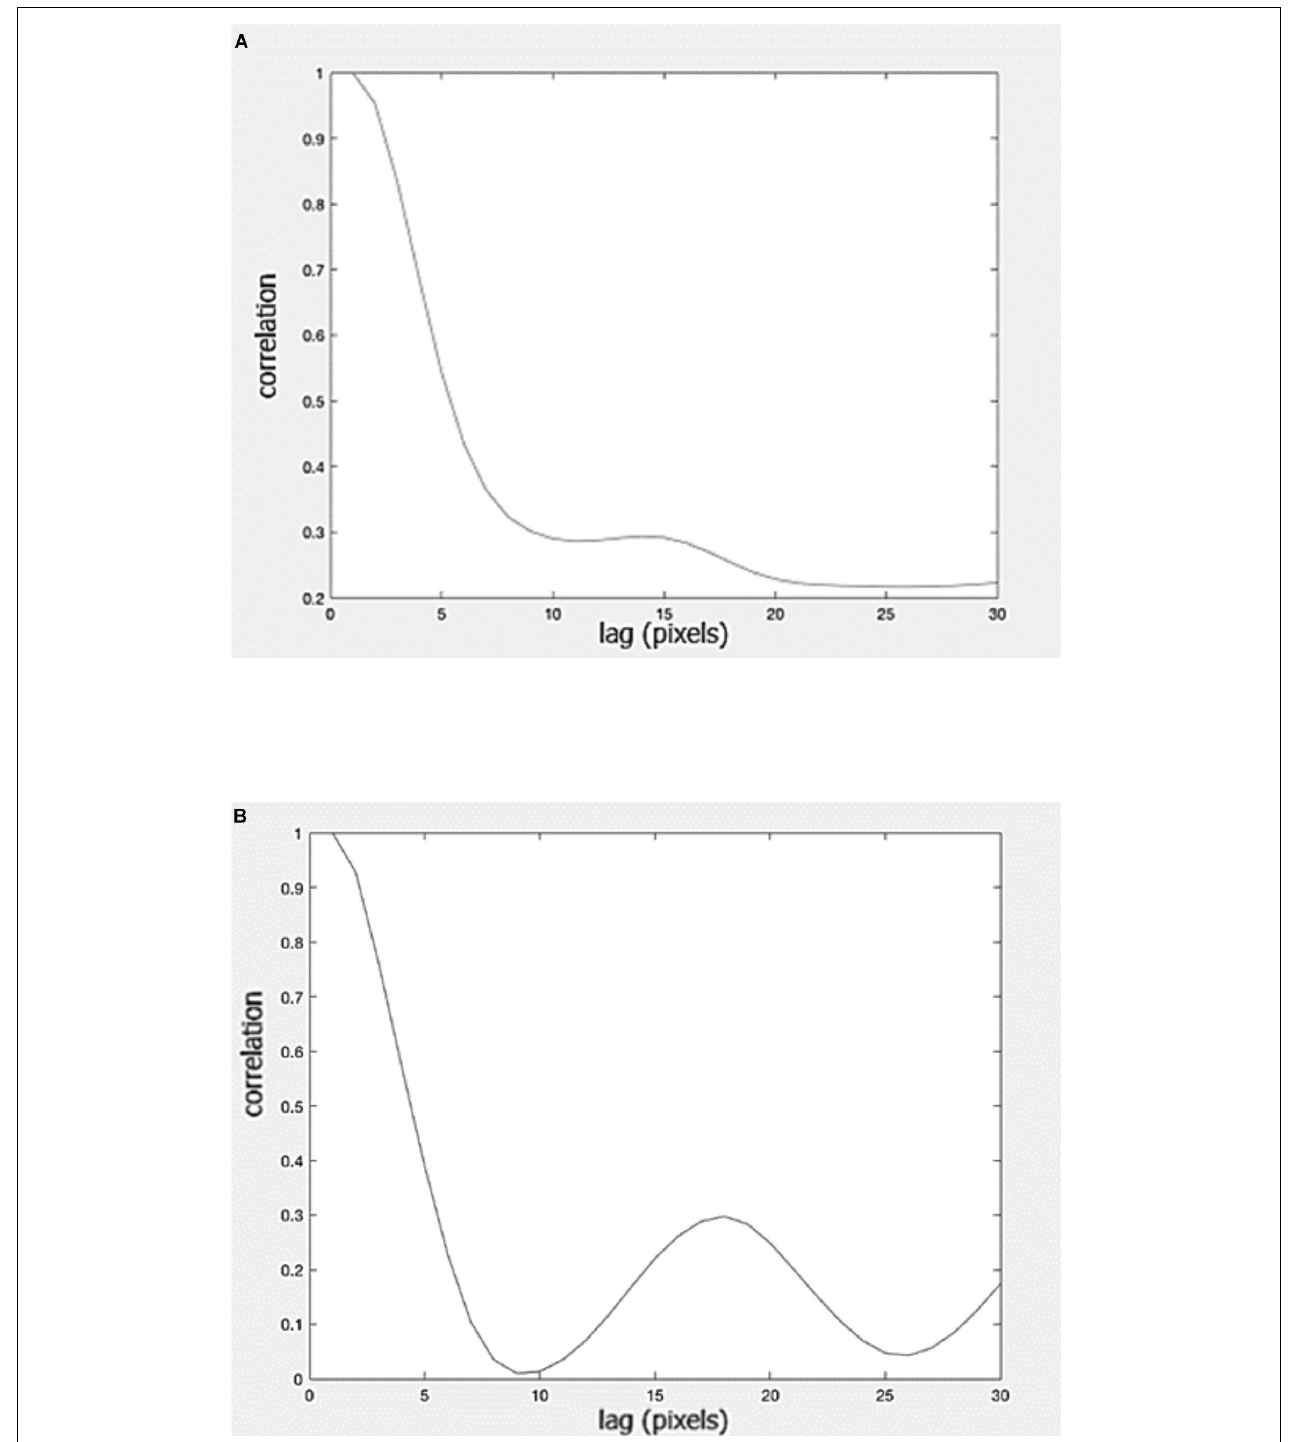
FIGURE 5 | Autocorrelation for the entire (A) Kannada and (B) English versions of the rate of reading test.